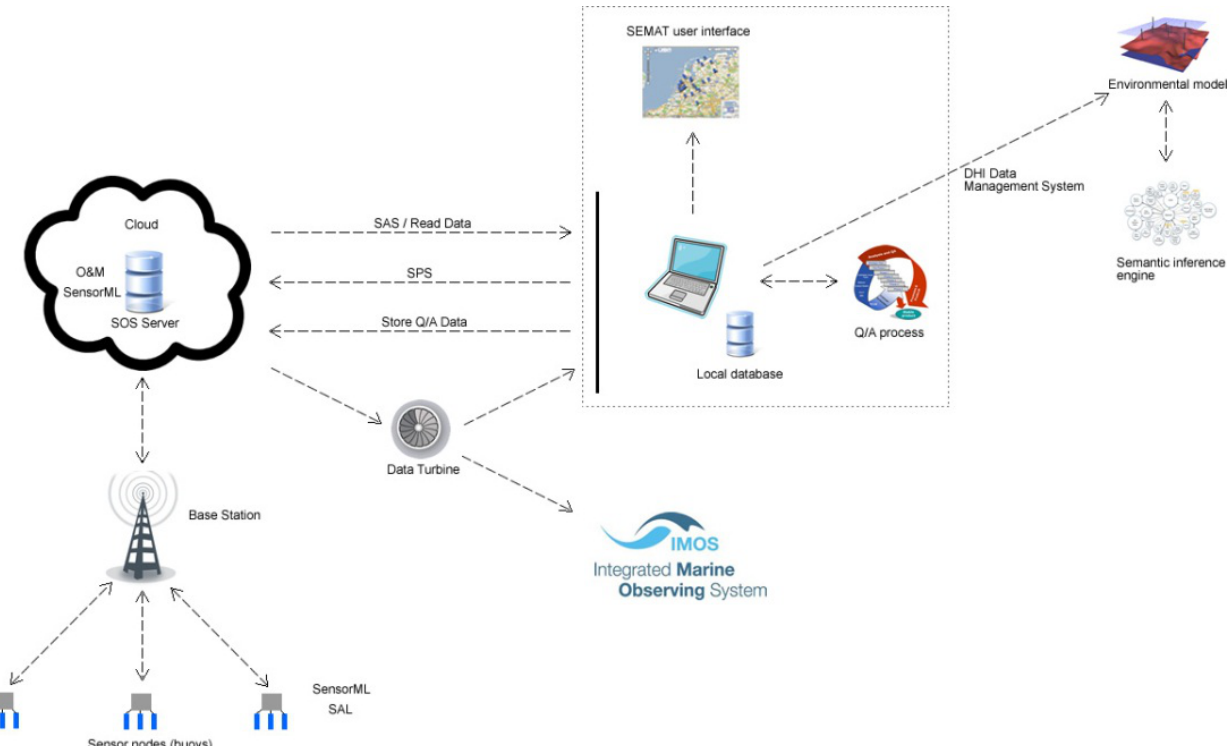
Figure 24. The complete SEMAT Mk3 software